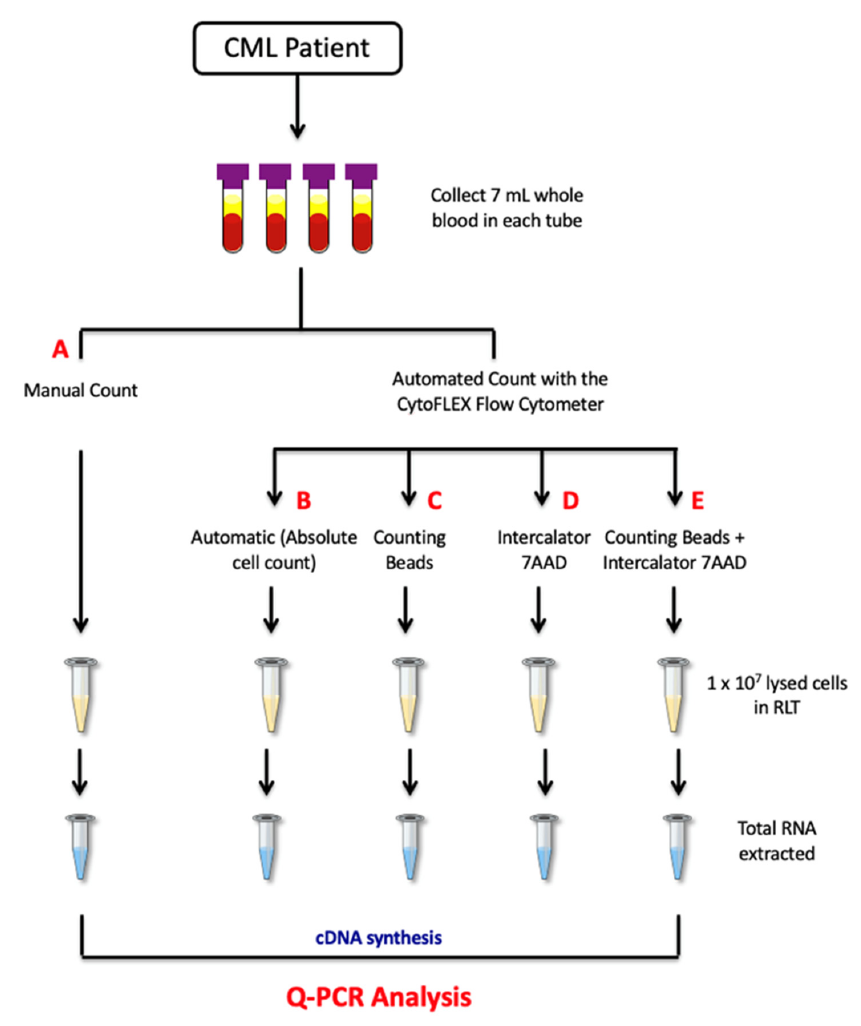
Figure 1. Workflow of the study. A total of 28 mL of peripheral blood from CML patients was collected within a single blood draw, in sterile 4 × 7 mL EDTA tubes. Total white blood cells (WBC) were isolated using the Biomek i-5 Automated Workstations and re-suspended in phosphate buffered saline (PBS). Next, a count was carried out by the manual ( A ) and the automatic methods via the CytoFLEX instrument ( B – E ). In the manual methods, samples were diluted and counted using the hemocytometer counting-chamber with a microscope. In the automatic method, four different measurements were tested: the automatic absolute protocol, the automatic assay using counting beads, the automatic protocol with 7-Aminoactinomycin Dye (7AAD) solution, and the automatic method based on the use of either counting beads and 7AAD. Next, 1 × 10 7 of the collected cells were lysed in RLT buffer and total RNA was isolated from matched samples. Finally, quantitative polymerase chain reaction (Q-PCR) was used to measure BCR-ABL1 and ABL1 gene transcript levels. EDTA tube: EthylenDiaminoTetracetyc Acid tube; RNA: RiboNucleic Acid; Q-PCR: quantita-